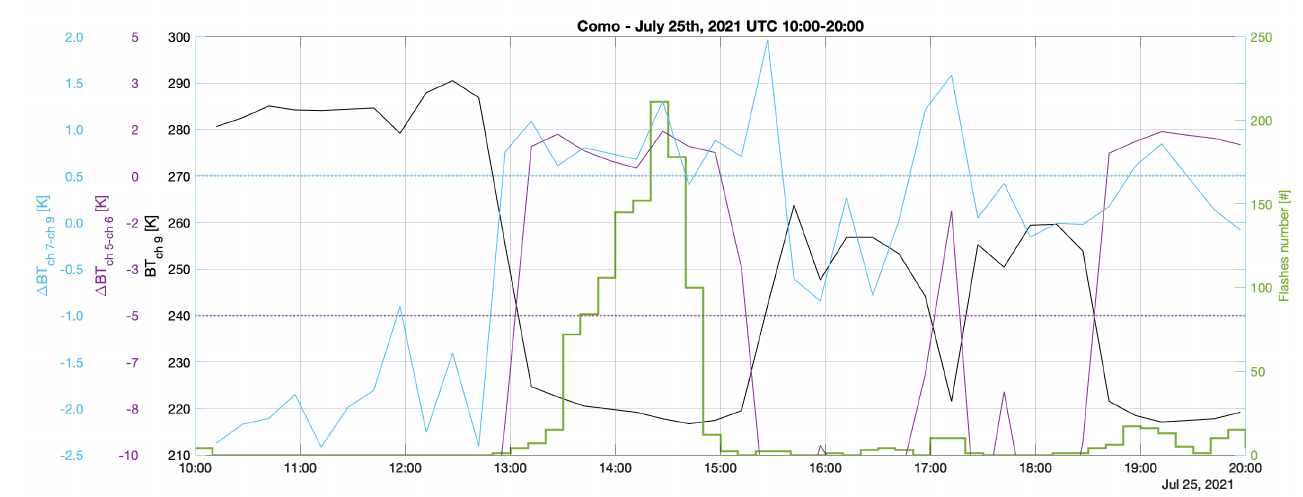
Figure 8. Analysis of the most intense part of the event, between 10 a.m. and 8 p.m. on 25 July 2021. MSG SEVIRI data (cloud top temperature—[Ch9] black line, presence of ice at the top of the cloud—[Ch7-Ch9] cyan line and cloud thickness—[Ch5-Ch6] purple line (Table 1)) and lightning data from LINET network (green line).